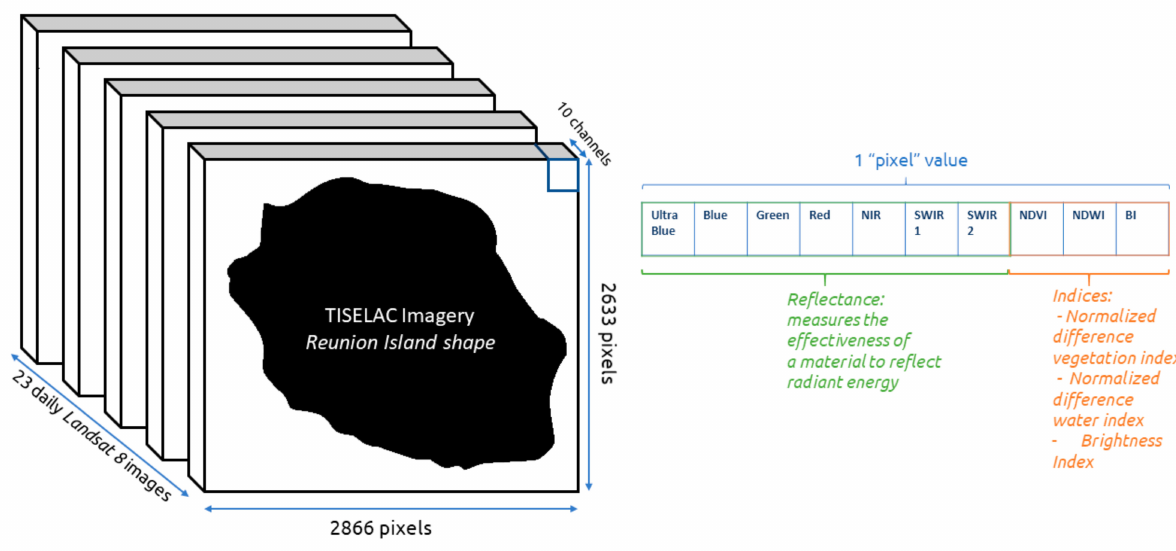
Figure 2. Timeseries landcover dataset with 23 images with the